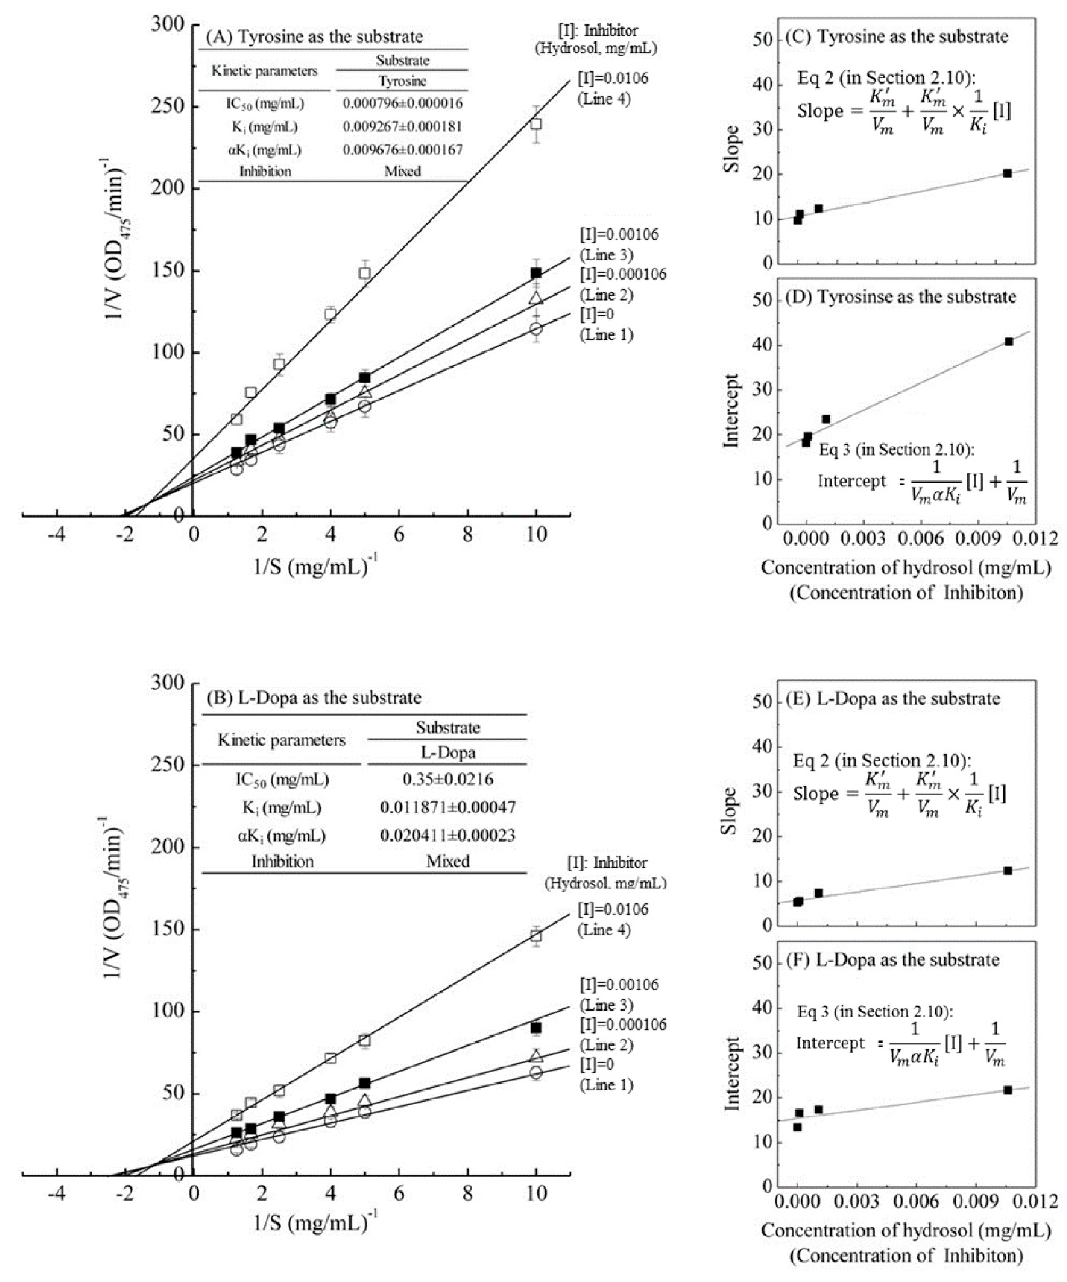
Figure 4. Lineweaver–Burk plots of L-tyrosine and L-DOPA catalysis by mushroom tyrosinase in the presence of inhibitor (hydrosol) at various concentrations. Concentration of inhibitor (hydrosol) for line 1–4 were 0, 0.000106, 0.00106, and 0.0106 mg / mL, respectively; ( A ) L-tyrosine substrate; ( B ) L-DOPA substrate; insets in ( C , E ) and ( D , F ) show secondary plots of slopes and intercepts of the straight lines versus inhibitor (hydrosols) concentrations, indicating K i and α K i values for L-tyrosine and L-DOPA respectively; K i , dissociation constant for inhibitor binding with free enzyme; α K i , dissociation constant for inhibitor binding with the enzyme-substrate complex. Equations (2) and (3) are detailed in Section 2.10.